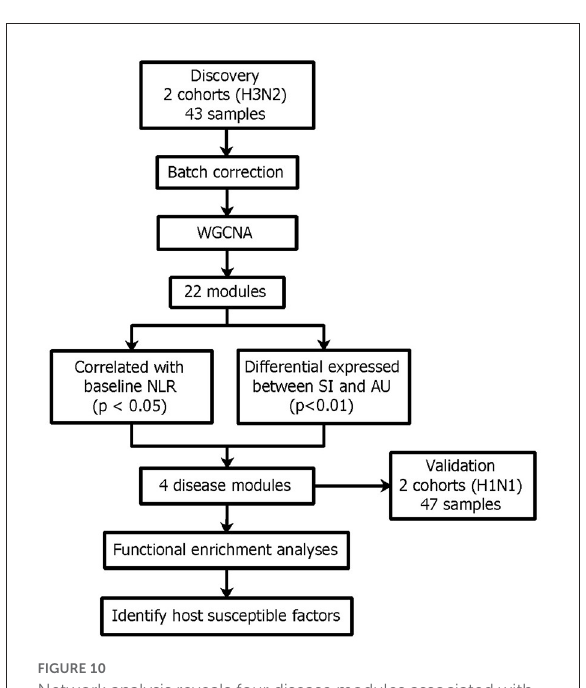
FIGURE10 Network analysis reveals four disease modules associated with the baseline NLR and also differentially expressed between the SI and AU groups.